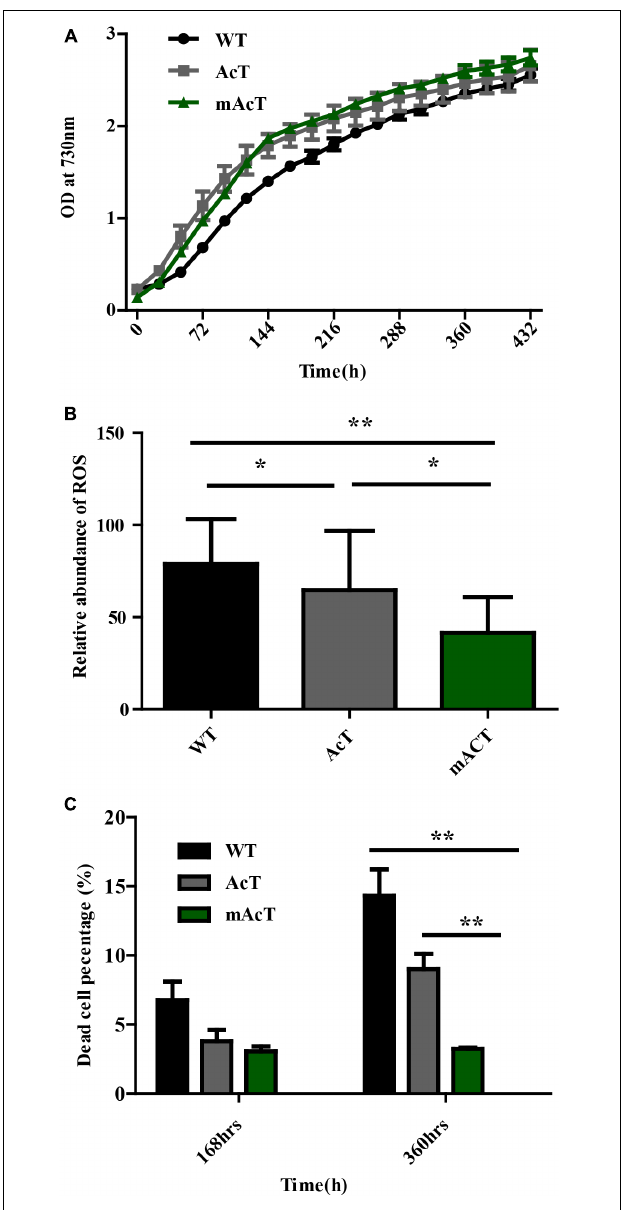
FIGURE 5 | Effects of FFA production on cell survivability. (A) Growth pattern of fatty acid-producing strains. The culture was grown in 250 mL culture flask at 30 ◦ C in a BG-11 medium under continuous illumination of 25 µ mol photons m − 2 s − 1 light. OD was measured at 730 nm. Data shown here are the mean ± SE from biological triplicates. (B) Cellular toxicity and ROS generation in WT, AcT and mACT strains at 168 h. Data shown here are the mean ± SE from five biological replications along with four technical replications and ‘ ∗ ’ represents statistical significance as indicated by Student’s t -test with a maximum p-value of < 0.05. (C) Percentage of damaged cells of WT, AcT and mAcT strains sorted by flow cytometry using SYTOX green nucleic acid stain. Data shown here are the mean ± SE from biological triplicates.